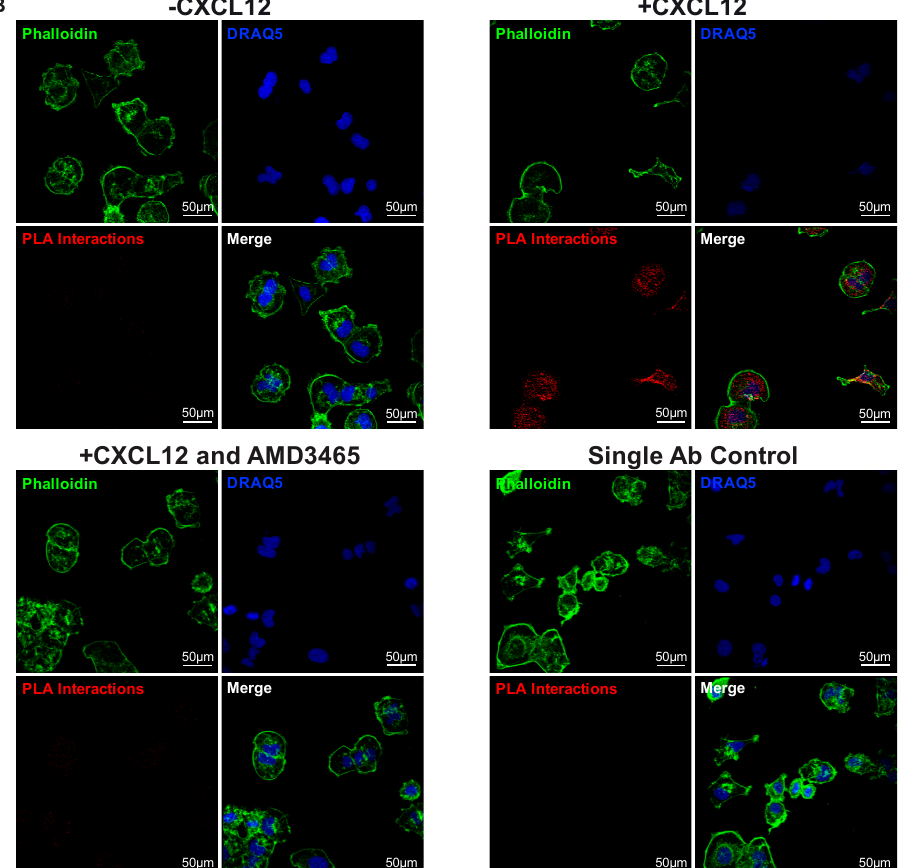
Figure 2. CXCR4-Dependent Association of LASP1 with Ago2 in situ. ( A ) Co-immunoprecipitation of Ago2 with LASP1 after stimulation of 231S cells with 20 nM CXCL12 for 0–60 min, with added unstimulated mock control and 30 min stimulation with added 100 nM AMD3465. Total protein lysates were resolved by 10% SDS-PAGE and immunoblotted for LASP1 and Ago2 ( n = 3). ( B ) Proximity ligation assay of the LASP1-Ago2 interaction in Bone-Un cells under four conditions: 20 nM CXCL12 stimulation for 30 min(+ CXCL12); 20 nM CXCL12 stimulation for 30 min with pre-treatment of cells with 100 nM AMD3465 for 30 min (+ CXCL12 and AMD3465); unstimulated Bone-Un cells ( − CXCL12); and single antibody control with no Ago2 antibody. The interactions were visualized as immunofluorescent dots (pseudo-colored red), the cellular outlines were marker by F-actin staining with Phalloidin (pseudo-colored green), and nuclei by DRAQ5 (pseudo-colored blue). Merged images of all three channels are provided ( n = 2). ( C ) Quantification of PLA interaction spots